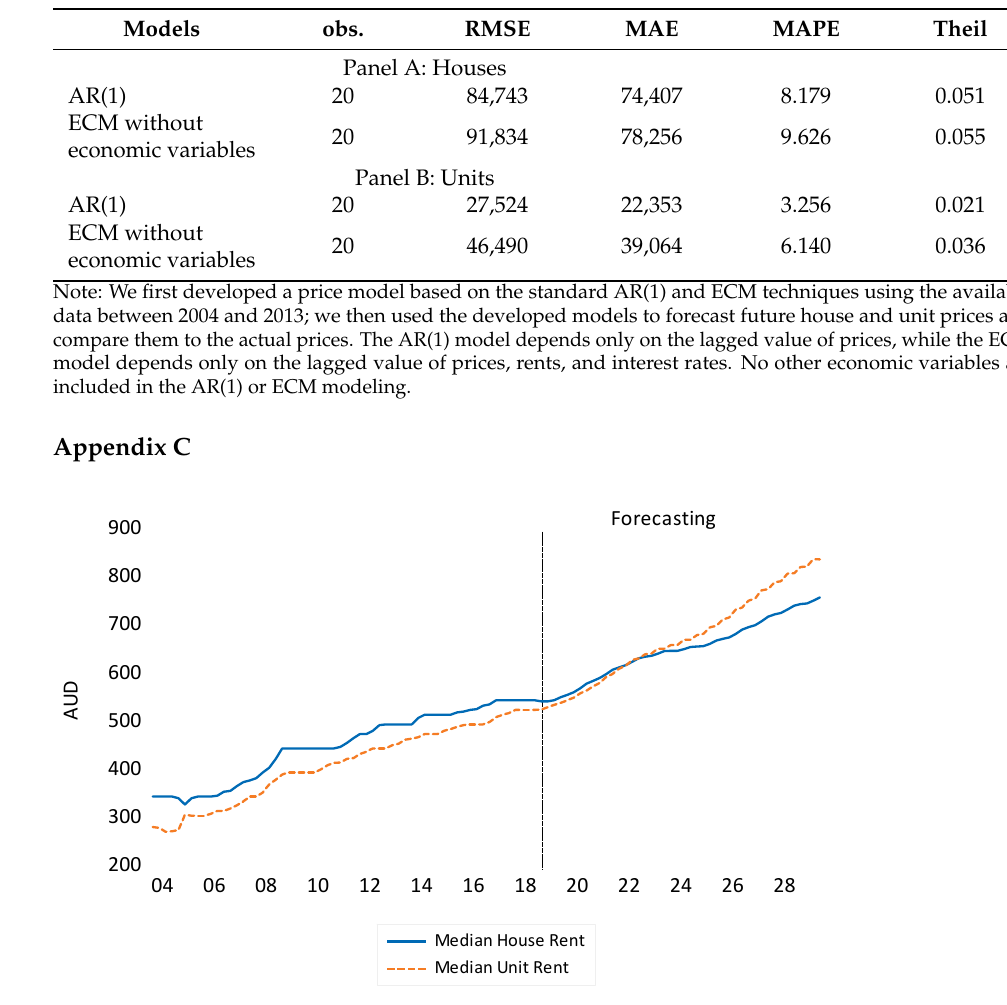
Table A2. Forecasting Performance by Alternative AR(1) and ECM Models.